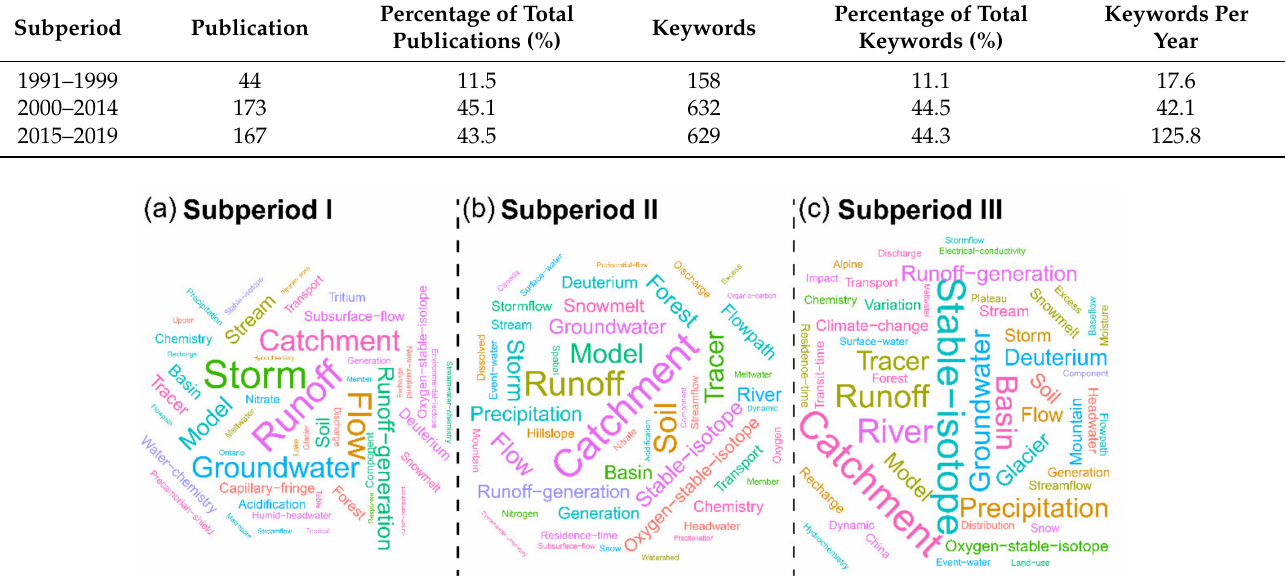
Figure 3. Word cloud of the most widely used IHS keywords in each subperiod. The size is proportional to the frequency of each keyword. The larger the word size is, the more important it is. For highlighting the important keywords, the keywords with high frequencies and large sizes locate in the center of the word could. ( a ) Subperiod I, ( b ) Subperiod II, ( c ) Subperiod III.